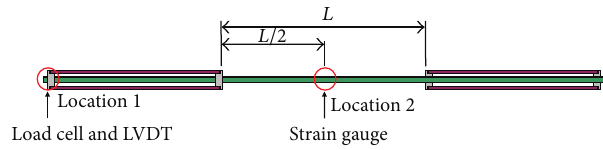
Figure 7: Sensor locations